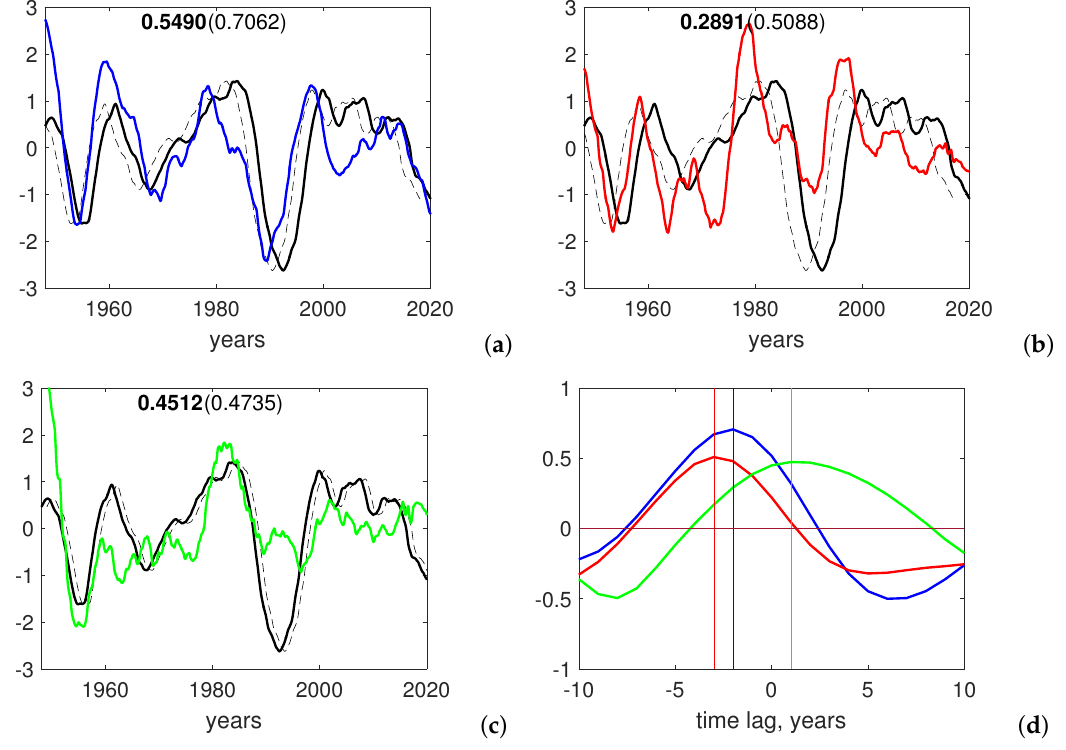
Figure 6. Time change in the rate of total ice growth averaged over the selected areas in comparison with the time variations of the first EOF mode principal component (black): ( a ) the ice growth rate in the CA region (blue), ( b ) the ice thickness decrease in the region B (red), ( c ) the rate of decrease in ice thickness in the region LK (green) ( d ) the value of the correlation coefficient of these time-series with the principal component depending on the time lag (in years). The geographical position of the areas is shown in Figure 5g. The dashed black line represents the principle component shifted in time by an amount corresponding to the maximum correlation. The first number from the graphs indicates the correlation coefficient of the main series, the second, in brackets, when there is an optimal lag